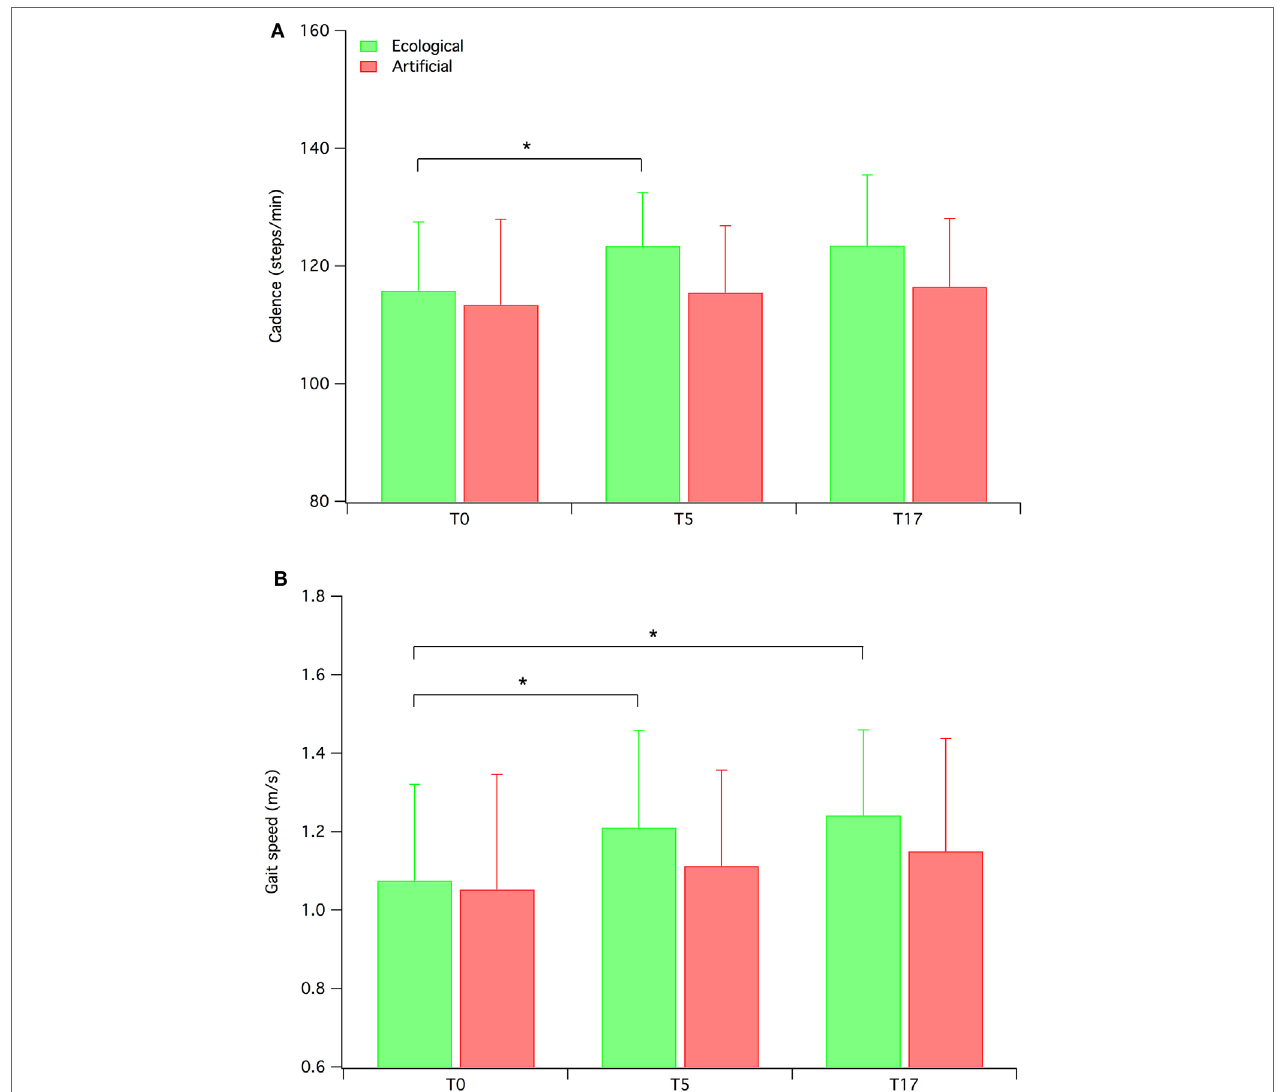
FiGUrE 3 | Mean cadence (a) and gait speed (B) for both ecological rhythmic auditory stimulation (RAS) participants and artificial RAS participants. Error bars represent